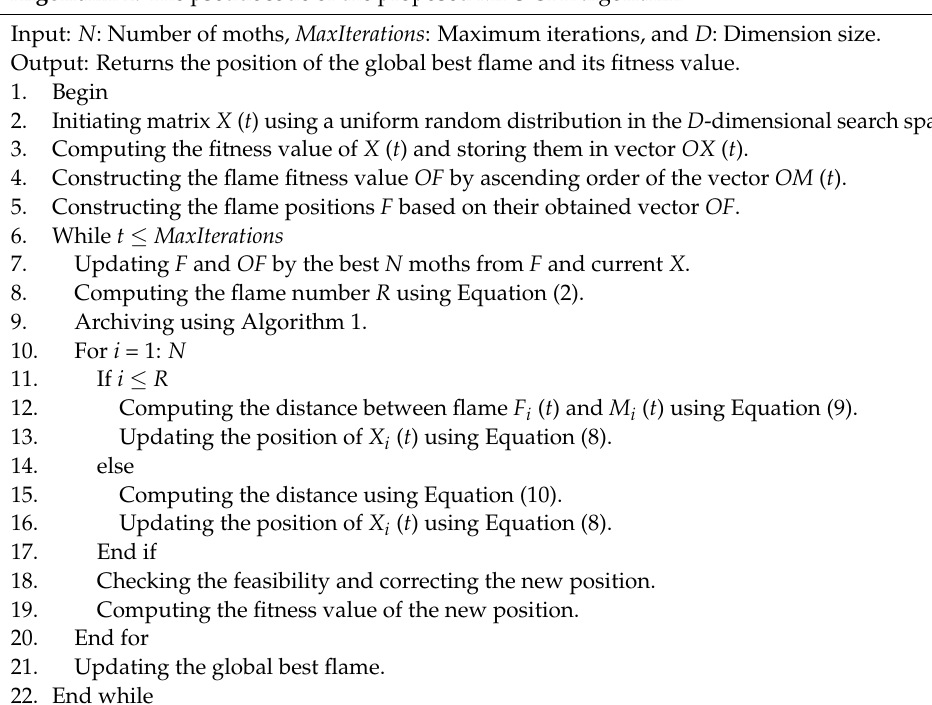
Algorithm 2. The pseudocode of the proposed MFO-SFR